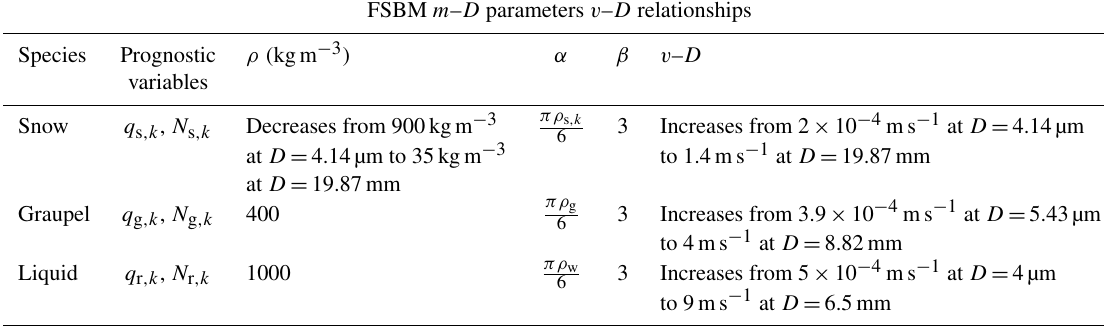
Table 3. FSBM mass–size relationship ( m = αD β ) parameters and terminal velocity ranges as a function of size ( v – D ). Note that the snow density varies by bin, and thus a range is given. Ranges are also given for all v – D relationships. The subscript k for prognostic variables refers to the k th size bin for a given